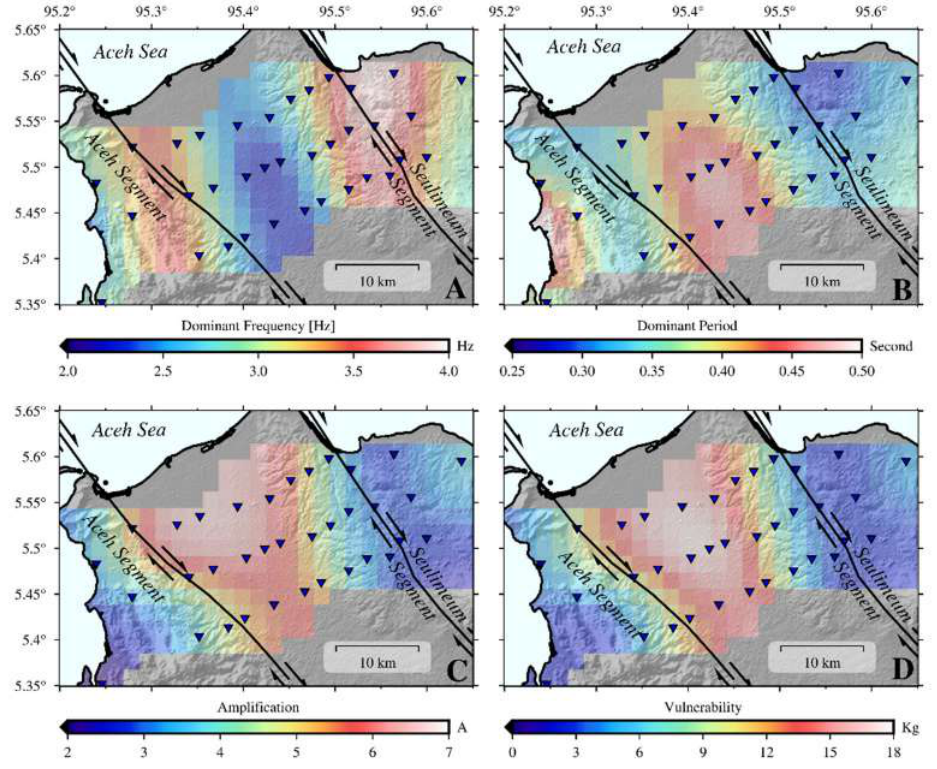
Fig. 7: Maps of (a) dominant frequency, (b) dominant period, (c) amplification, and (d) vulnerability index resulting from HVSR analysis while the closer to 1 correlation value indicates a between parameters. The frequency parameter positive correlation between the two parameters. strongly correlates to shear wave velocity at a depth The values closer to -1 also indicate a good correlation of 20 m but almost independent seismic amplification.